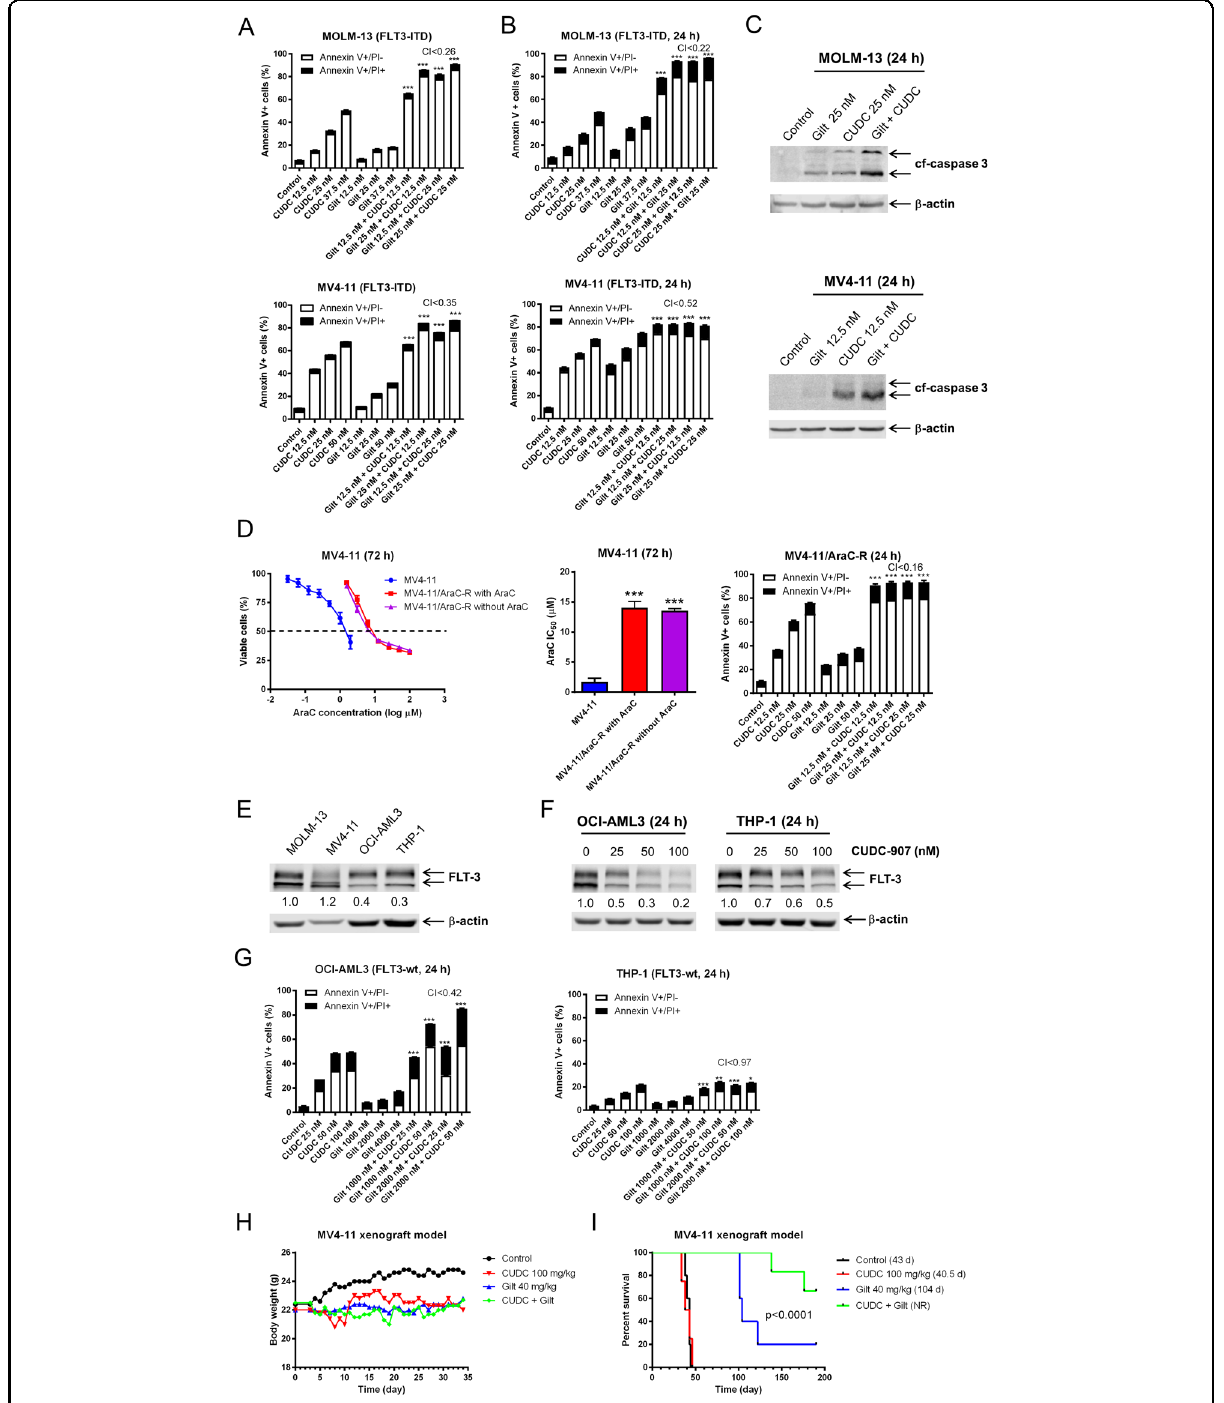
Fig. 2 (See legend on next